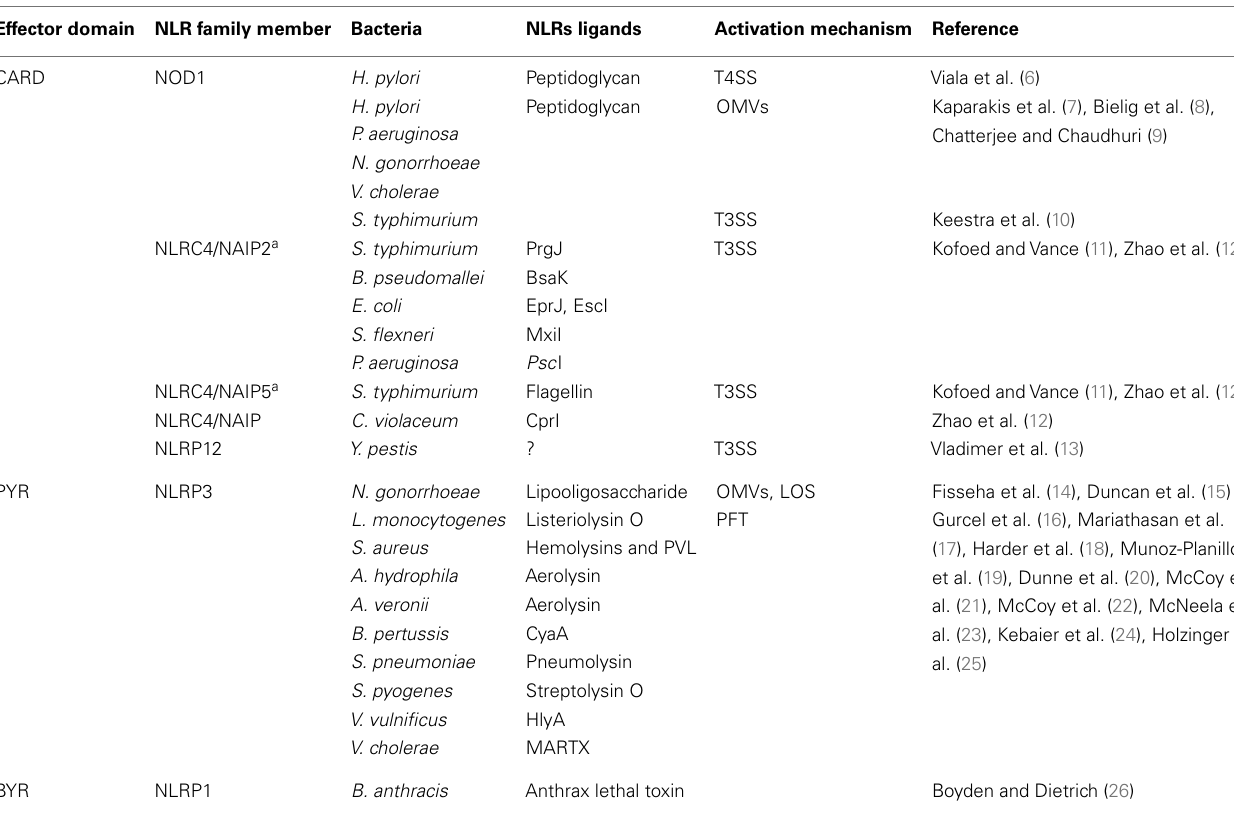
Table 1 | NLR family members and bacterial